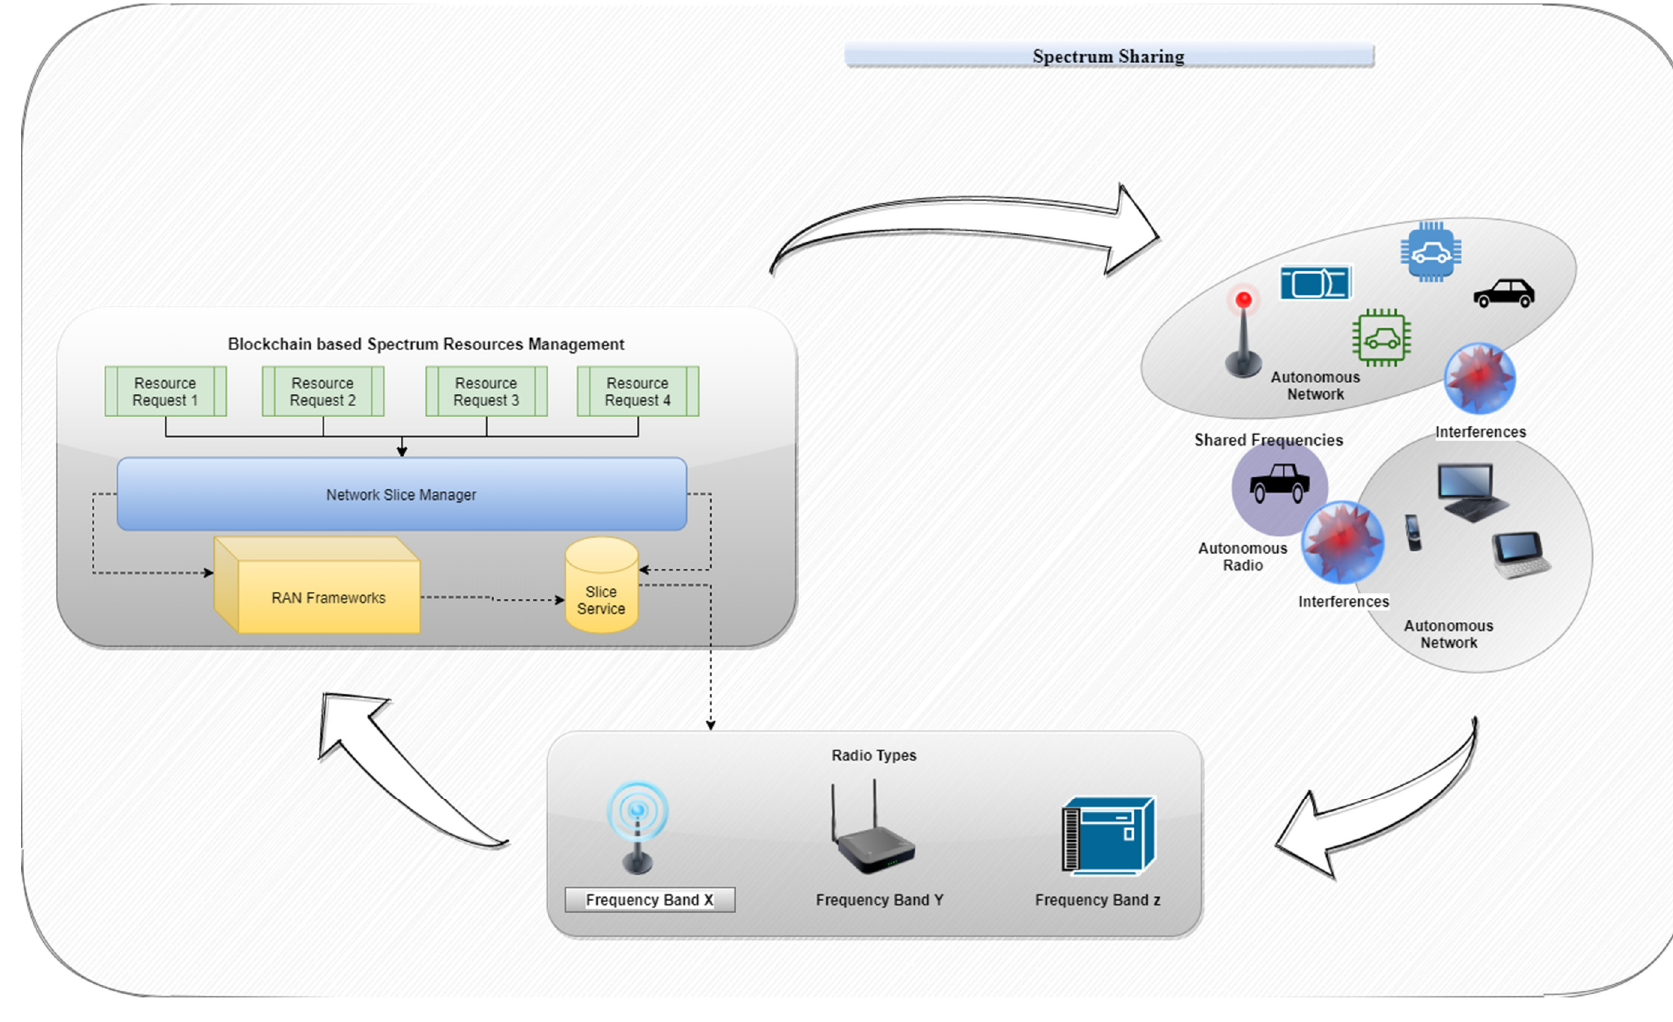
Figure 2. Dynamic spectrum-sharing environment.